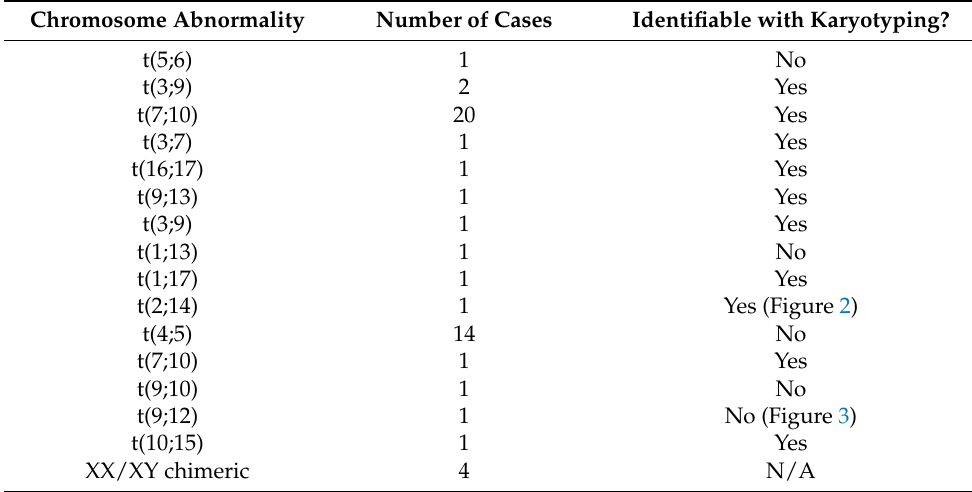
Table 1. Summary of porcine screening results from 2016–2019 using the multiprobe FISH method and standard